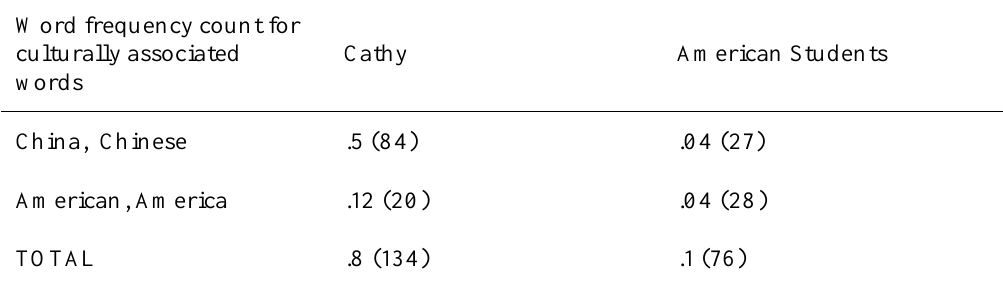
Results of Frequency Counts for Words China/Chinese , U.S./US/USA , and